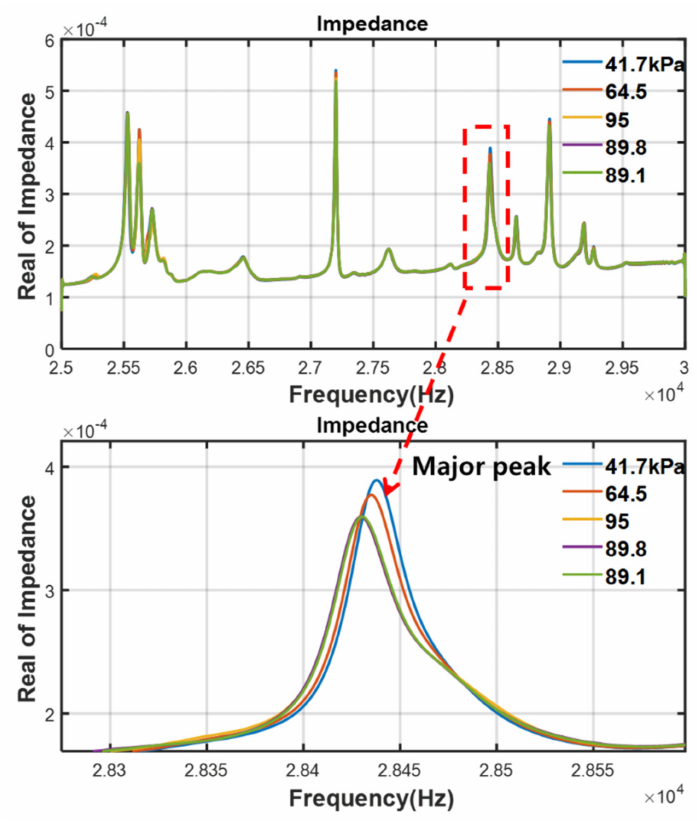
Figure 6. Variations in EMI according to internal pressure (test 4).